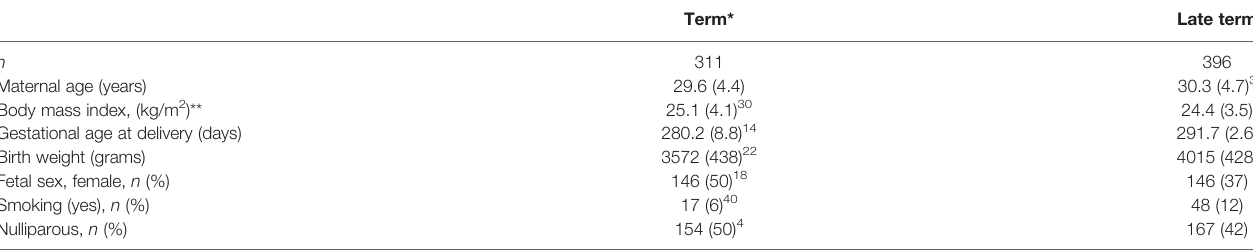
TABLE 1 | Clinical characteristics of the two study groups ( n =